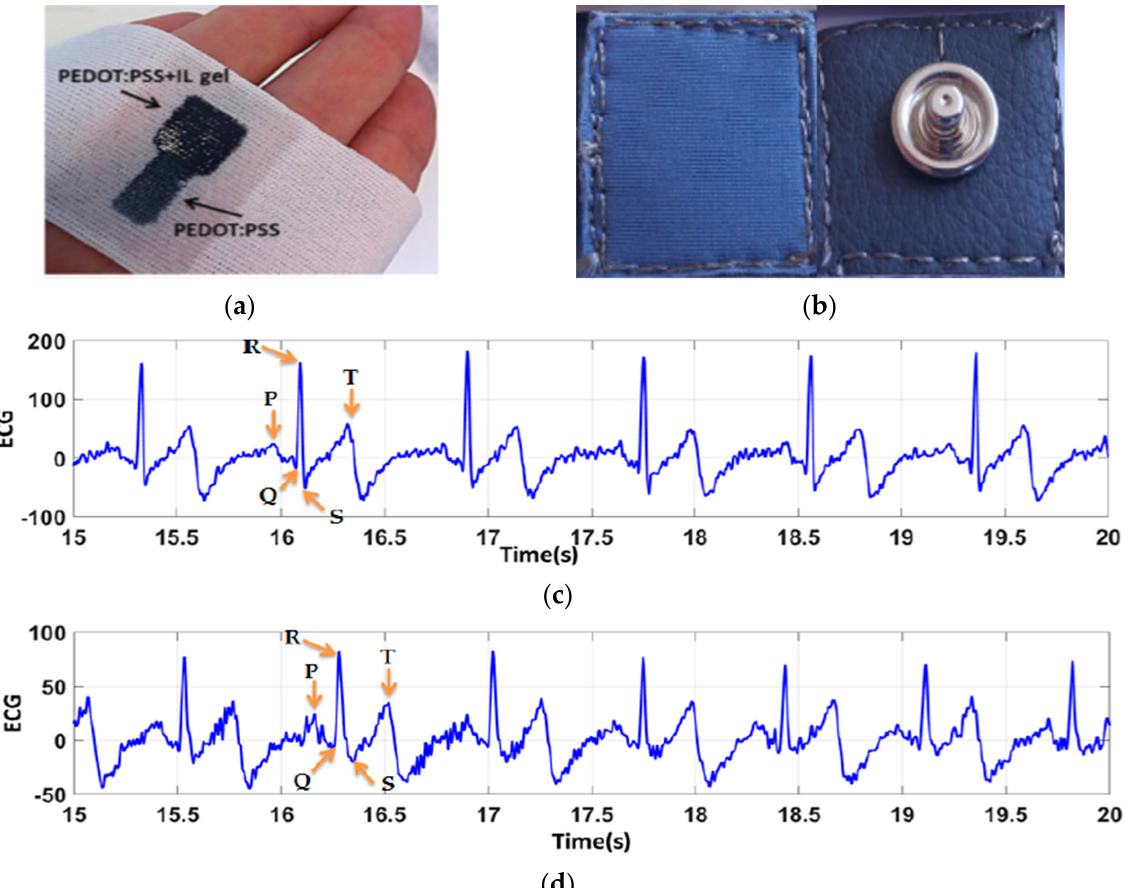
Figure 7. Conductive polymer-coated textile electrodes: ( a ) PEDOT:PSS and ionic liquid gel-coated polyester textile electrode, adopted from [23]; ( b ) PEDOT:PSS-coated textile electrode, adopted from [96]; ( c ) ECG signal collected from PEDOT:PSS-coated textile electrode before washing; and ( d ) after 50 washing cycle, adopted from [92]. The ECG signals collected using textile electrodes show 25.5 dB SNR before washing and 10.3 dB SNR after 50 washing cycles.